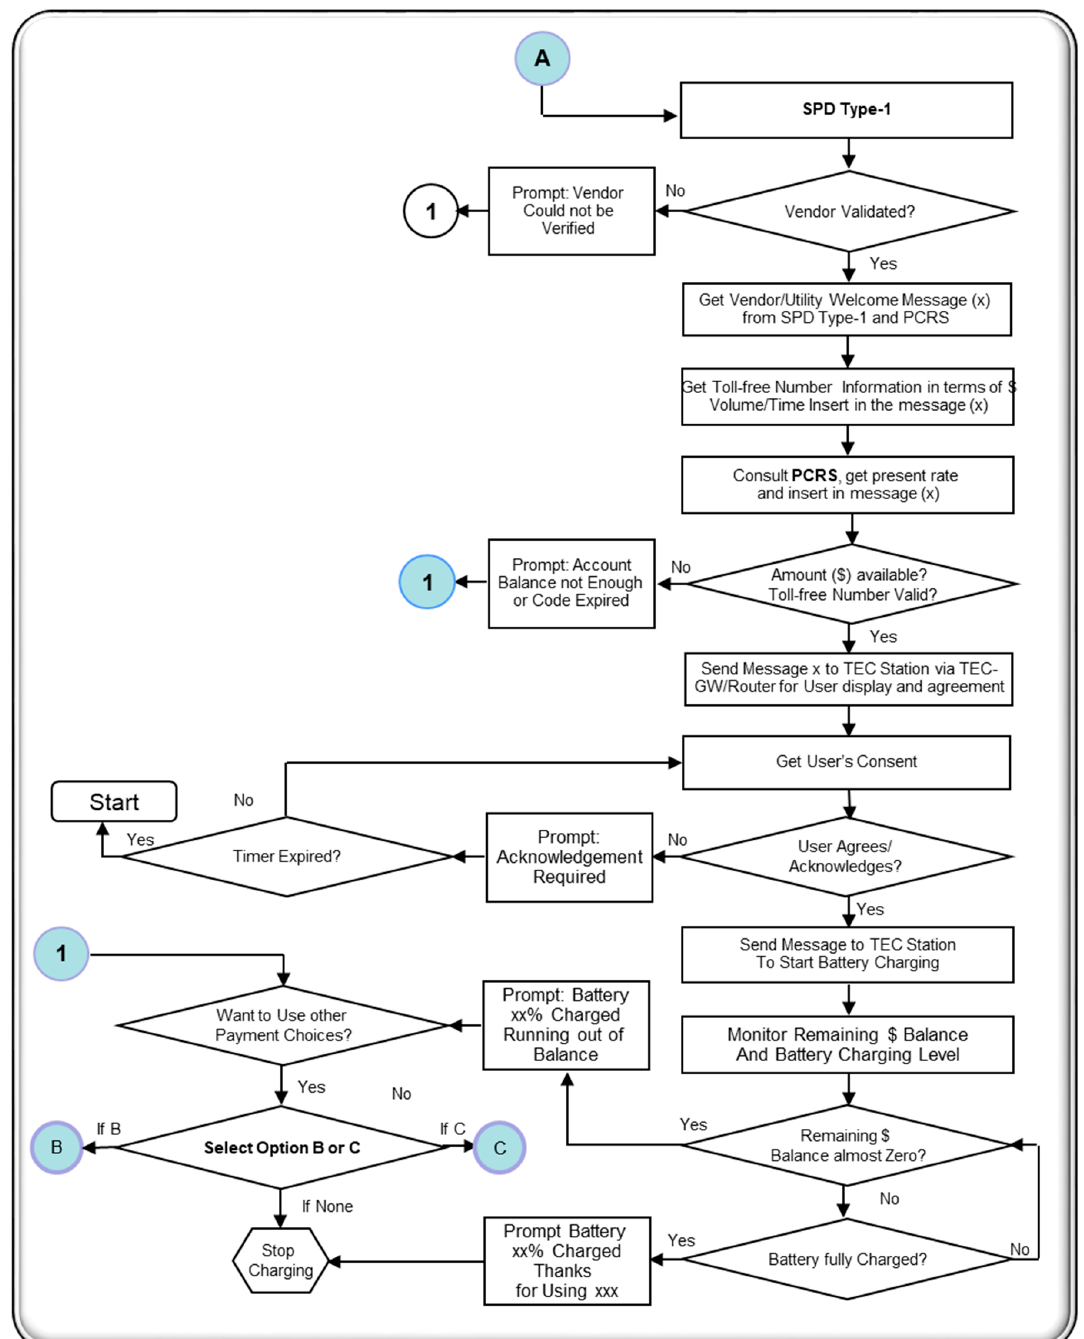
Figure 3. Toll-free service provisioning Type-1 (pre-existing toll-free service